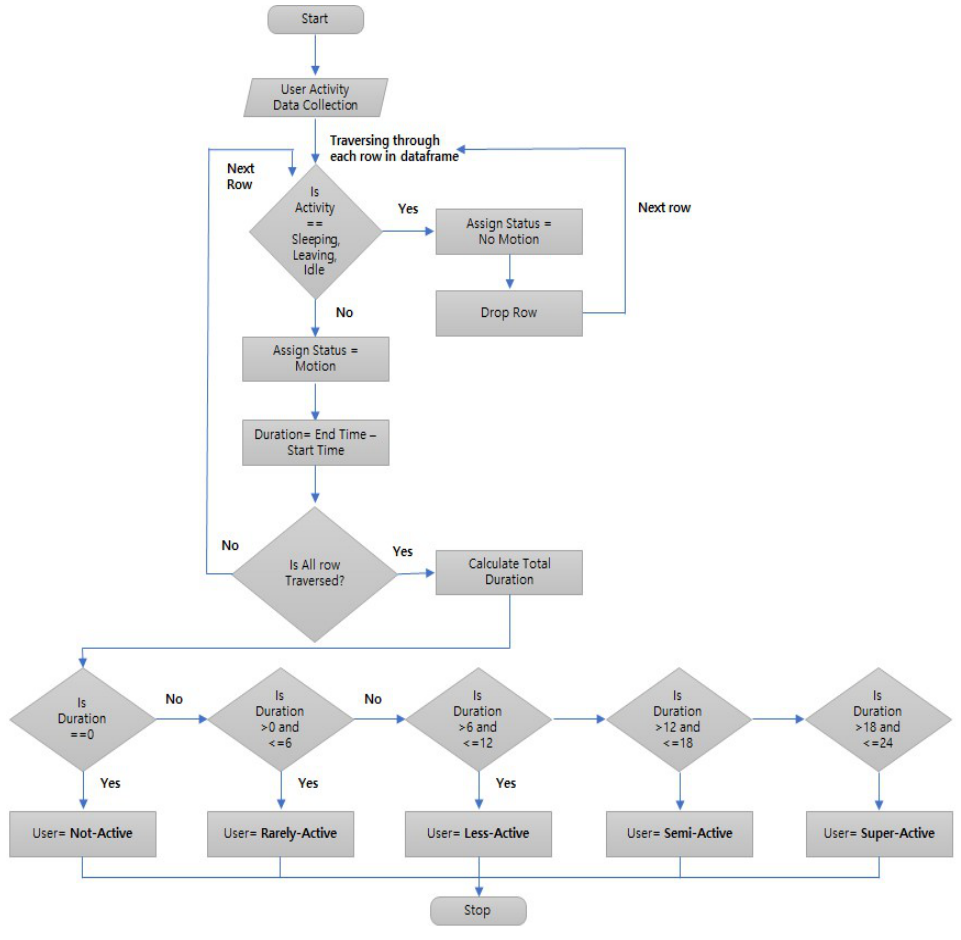
Figure 3. Flowchart for defining user classes. Table 5. Categorization of different appliances.